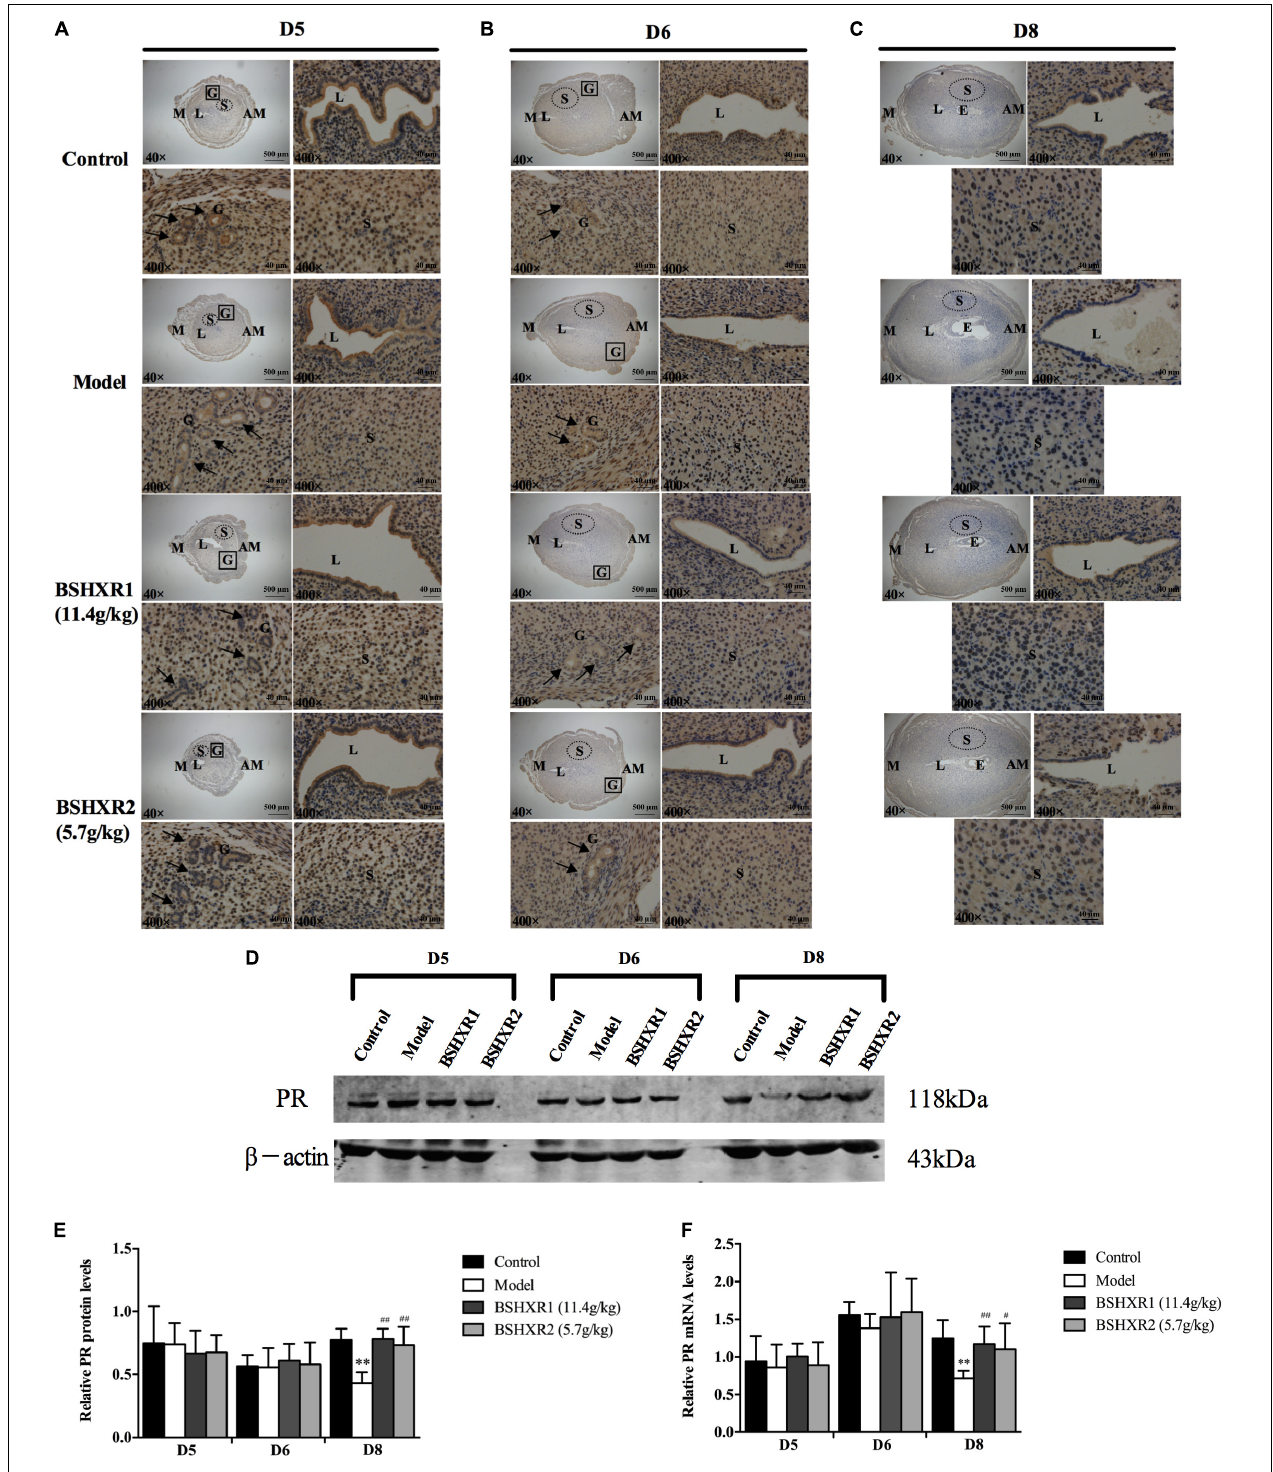
FIGURE 7 | PR expression in the uterus on D5, D6 and D8. (A) Immunohistochemistry of PR in paraffin sections of the uterus on D5 (A) , D6 (B) , and D8 (C) . For each group (control, model, BSHXR1, and BSHXR2), a low magnification image of the uterus is depicted, as well as higher magnification images of the lumen (L), gland (G) and stroma (S). E, embryo; M, mesometrial; AM, anti-mesometrial; L, lumen; G, gland; S, stroma. Arrows indicate glands. Original magnification and scale bar were shown in images. (D) Protein levels of PR in pregnant uterus (remove embryo) by western blot analysis ( n = 3). (E) Quantification of PR protein expression. (F) mRNA levels of PR in pregnant uterus (remove embryo) by qRT-PCR ( n = 5). Data represent mean ± SD. β -actin was used as the reference. ∗∗ P < 0.01 when compared to control group. # P < 0.05 and ## P < 0.01 when compared to model